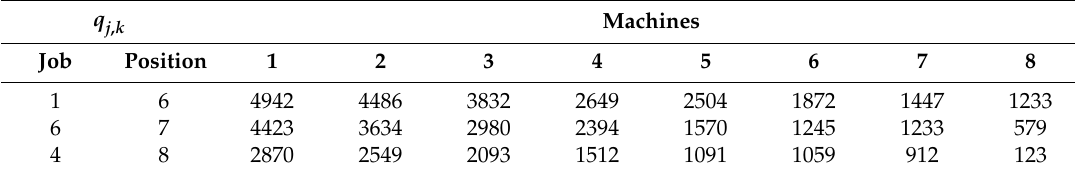
Table A4. Completion times of tails for { 2,1,6,4 } with C max =